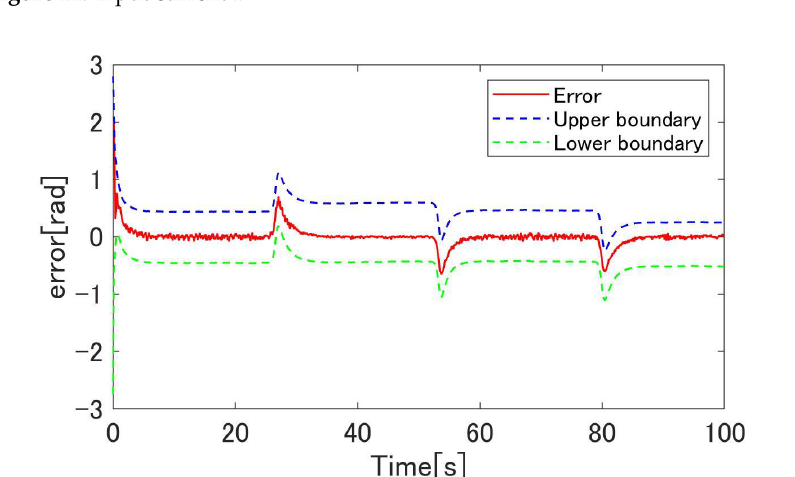
Figure 21. Input current u .